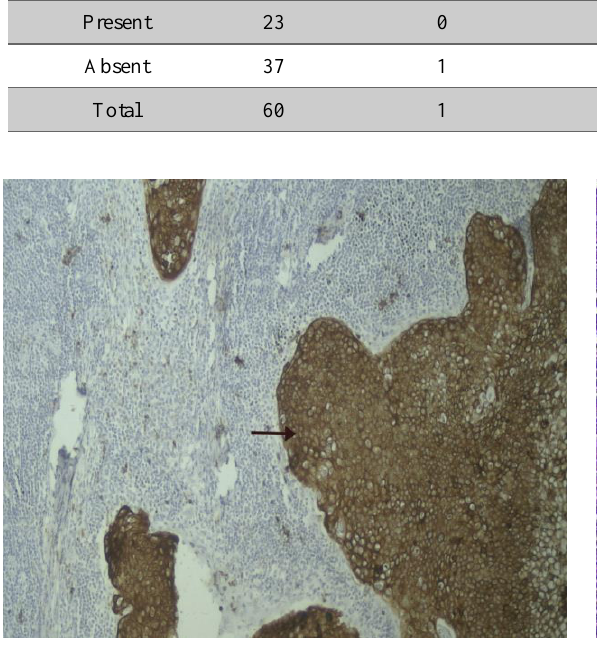
Figure 6. Metastatic melanoma to a lymph node